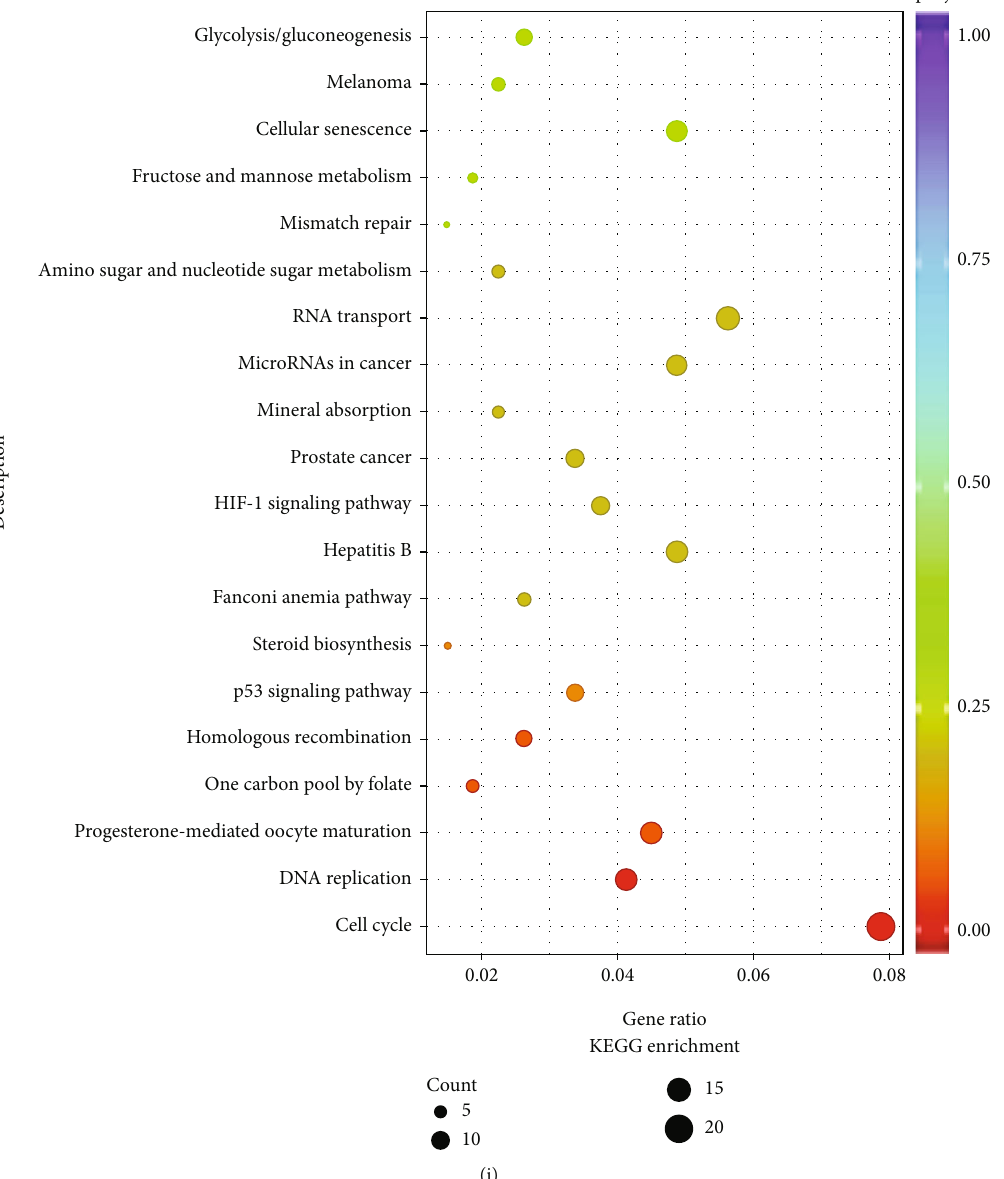
Figure 1: (a) Diagram of the Schwann cells and MC3T3-E1 cell coculture model; (b) representative images showing ALP staining; (c) ALP activity was measured with an ALP assay kit, n = 6, p = 0 : 0108 ; l; (d) representative images showing Alizarin red staining; l; (e) real-time RT- PCR (qPCR) analyses. ∗ P < 0 : 05 , Student ’ s t -test. N = 4 ; (f – i) transcriptome di ff erences between the coculture group and the control group in MC3T3-E1 cells; (f) the boxplots represent the distribution of expression levels; the ordinate is gene expression level; (g) volcano plot of di ff erential gene expression analysis; the dotted blue line indicates the threshold of the di ff erential genes selected; (h) cluster heatmap of di ff erentially expressed genes; (i) the KEGG enrichment scatter plot. The size of the black spots represents the gene number; the gradual color represents the P